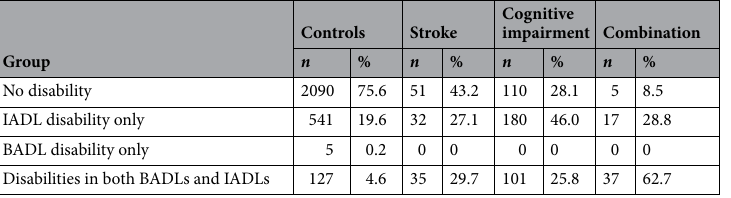
Table 2. Prevalences of disabilities in basic activities of daily living (BADLs) and instrumental ADLs (IADLs) among groups.